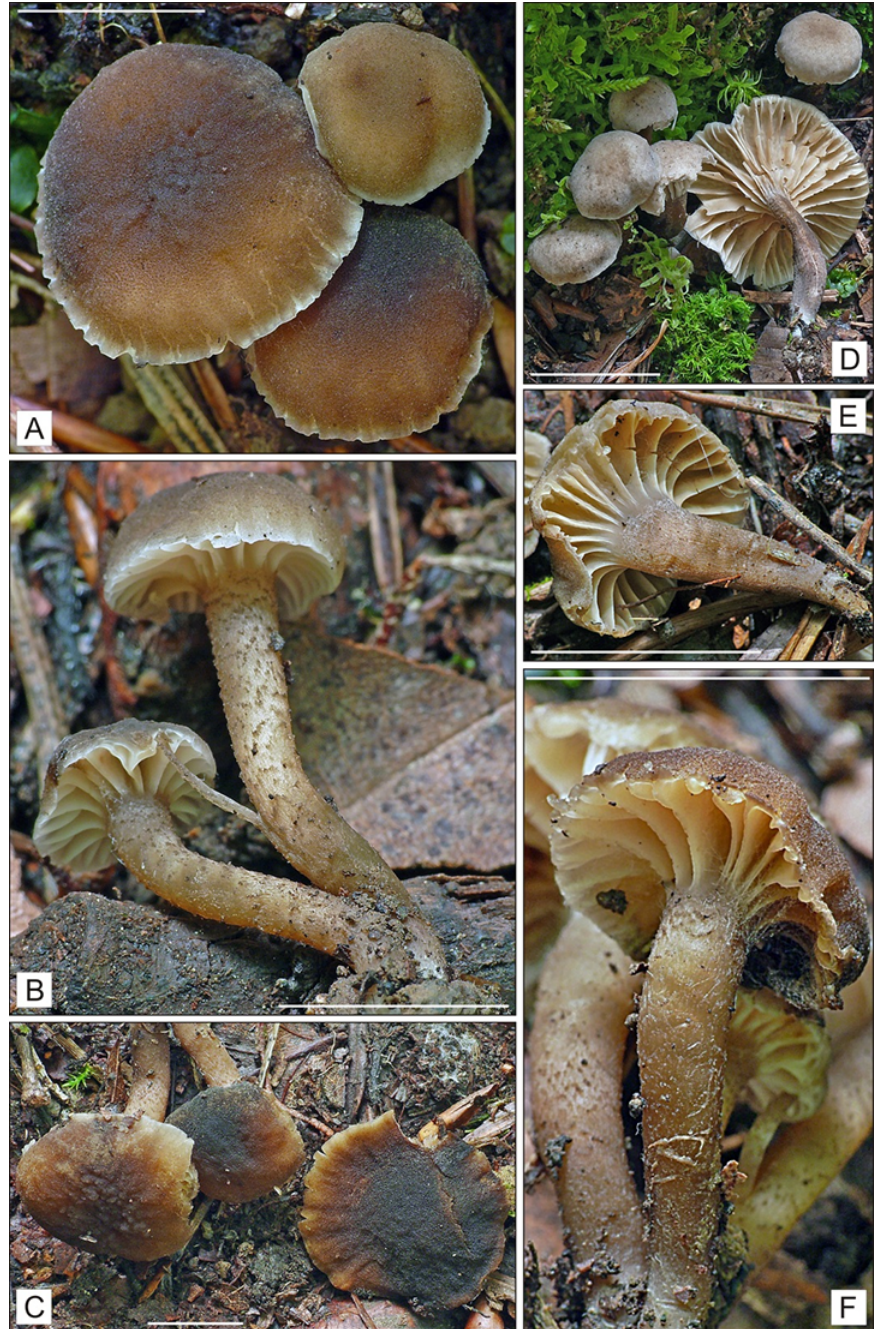
Figure 1 Hodophilus variabilipes Jančovičová, Adamčík & Looney. ( A–F ) Basidiomata: ChP-2016-0004 ( A–C,E,F ); ChP-2014-0007 ( D ). Scale bars: 10